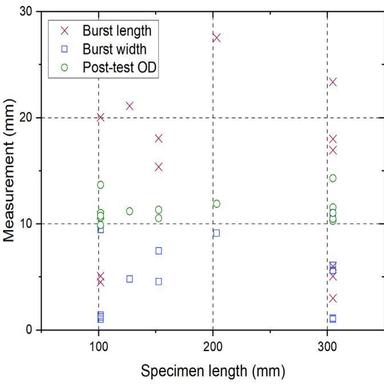
Distribution of burst measurements with respect to the specimen length.